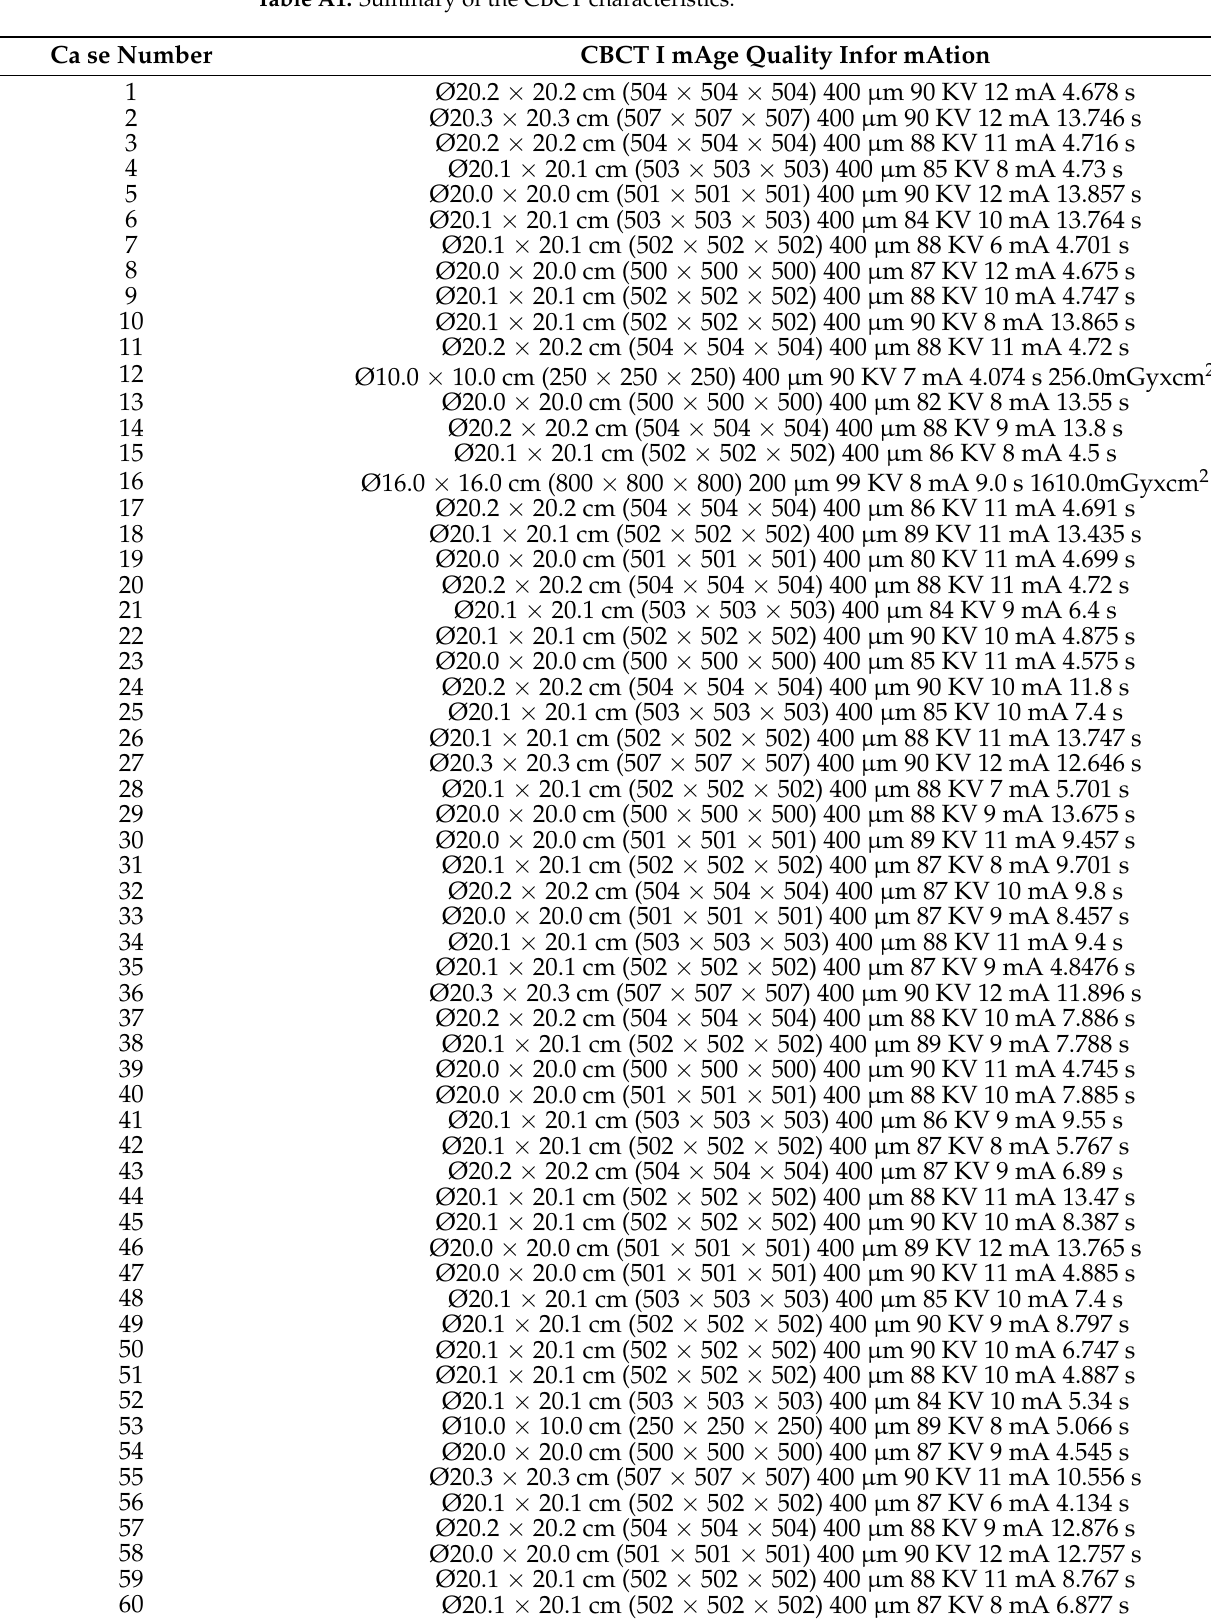
Table A1. Summary of the CBCT